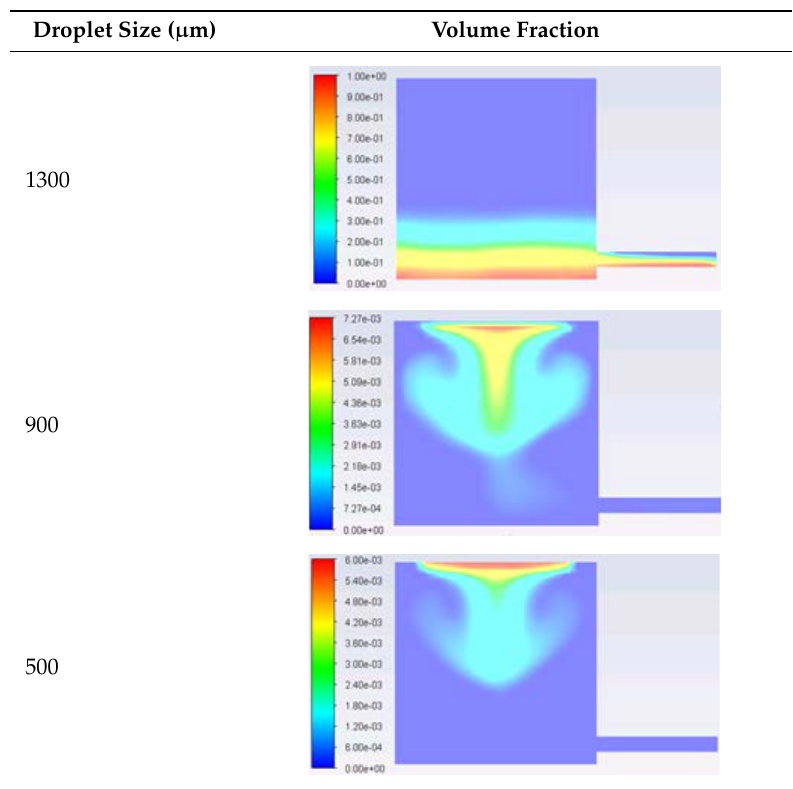
Table 3. Results for Luo [27] coalescence model.